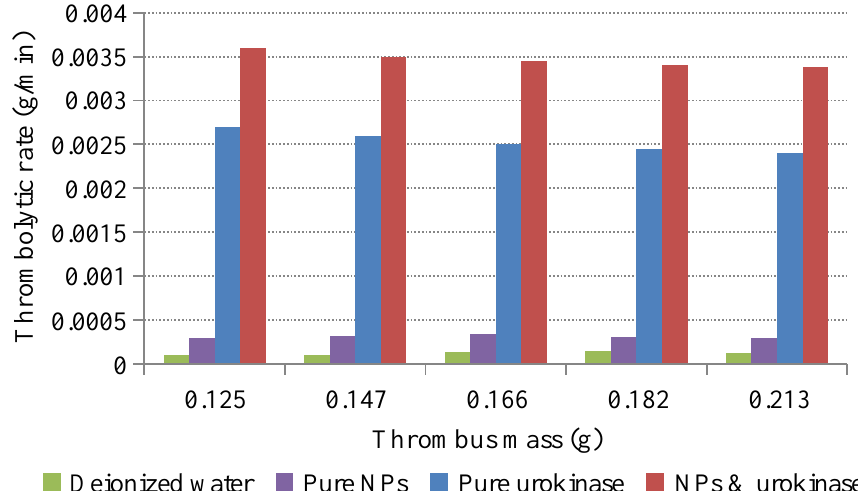
Figure 4. Comparison of thrombolytic rates for urokinase solutions with and without magnetic Fe 3 O 4 NPs.